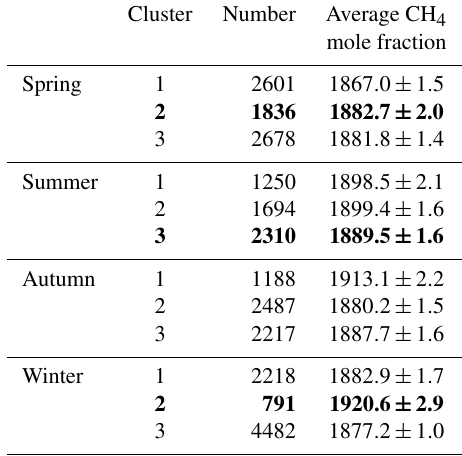
Table 3. The statistics for the cluster analysis result for hourly CH 4 data from 2004–2019 at the WLG station. The clusters from urban areas are highlighted in bold.